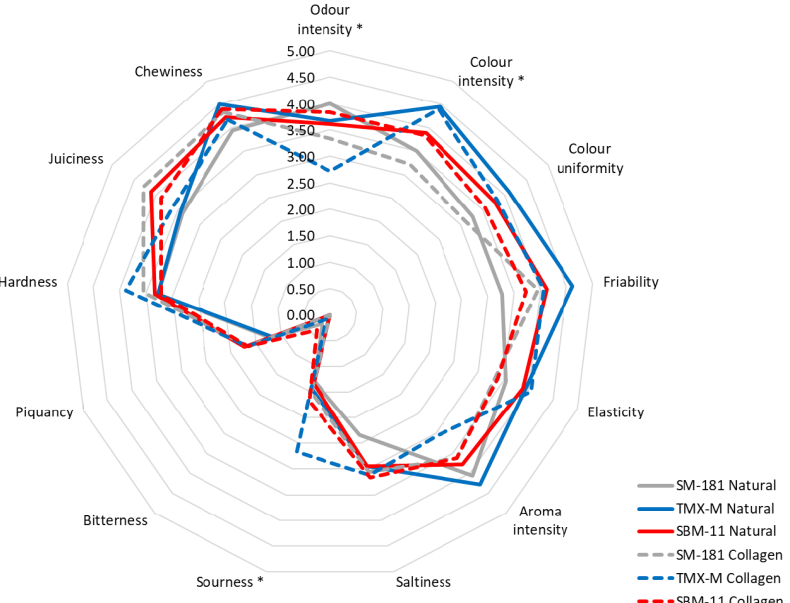
Figure 4. Sensory data attributed, at the end of ripening, to fermented sausages produced using different starter cultures and stuffed into different casings. For each attribute, the presence of an asterisk indicates significant differences between the samples.